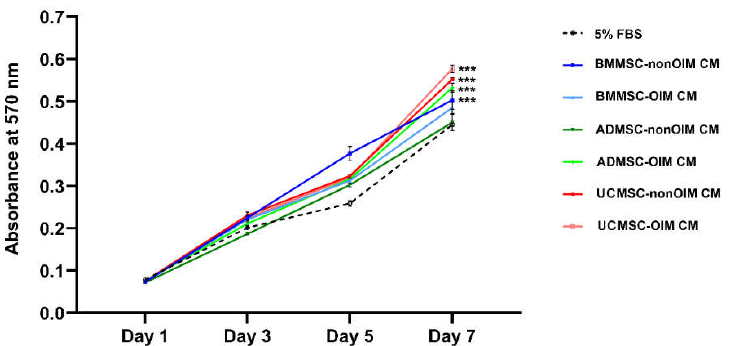
Figure 1. Cell proliferation of human umbilical vein endothelial cells treated with secretomes de- rived from osteo-induced (OIM) or noninduced (nonOIM) MSCs cultured on human decellularized bone matrix. The results showed that most of conditioned media could promote cell growth com- pared to the medium containing 5% FBS. Osteo-induced and noninduced UCMSC conditioned me- dia had a higher potential to induce cell proliferation compared to the other groups. The absorbance at each timepoint represents mean ± SEM. A one-way ANOVA with Tukey post hoc test was used to determine statistical significance at day 7 (*** p < 0.001).